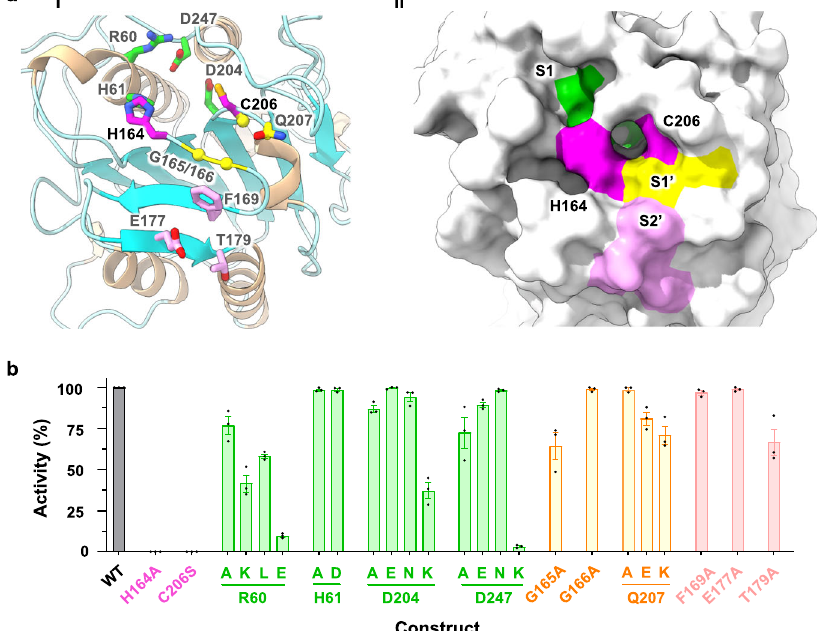
Fig. 2 Structural and functional resemblance of the PIGK active site to that of legumains. a Cartoon (wheat, α -helix; cyan, β -strand, i ) and surface ( ii ) representation of the PIGK protease domain with the catalytic dyad (magenta), S1 (green), S1 ′ (yellow), and S2 ′ (pink) residues shown as sticks ( i ) or highlighted in colors ( ii ). S1/S1 ′ /S2 ′ sites are superposed from legumain structures 44 . b Functional assay of the active site mutants. Apparent activity (% of wild-type, WT) was measured by immune staining of a reporter GPI-AP (CD59) on the surface of PIGK-KO cells transfected with the indicated mutants of the catalytic dyad and S1/S1 ′ /S2 ′ residues (color-coded to match those in a ). Cells expressing PIGK fused with a thermostable green fl uorescence protein 41 were gated, and the surface staining of CD59 was further analyzed by fl ow cytometry. Data represent mean ± s.e.m. from three independent experiments. Source data are